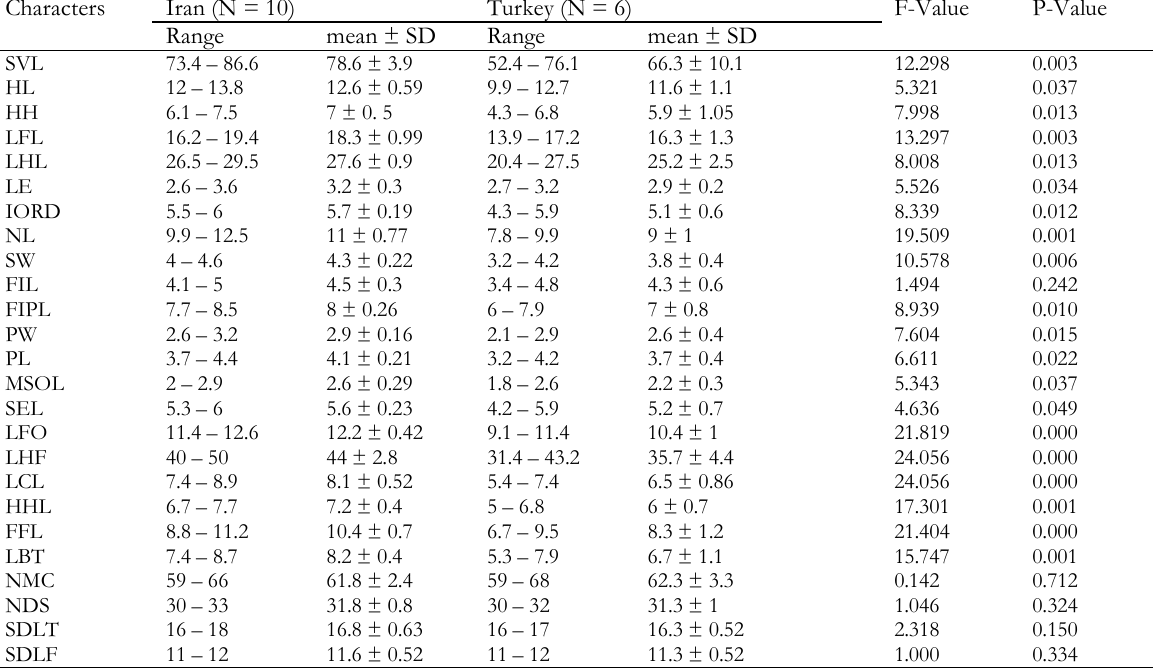
T ABLE 3. Results of One-way ANOVA (LSD-Test) and Independent sample t -test for measured characters of female specimens in two studied populations of T. vittata . Ranges, Mean ± Standard